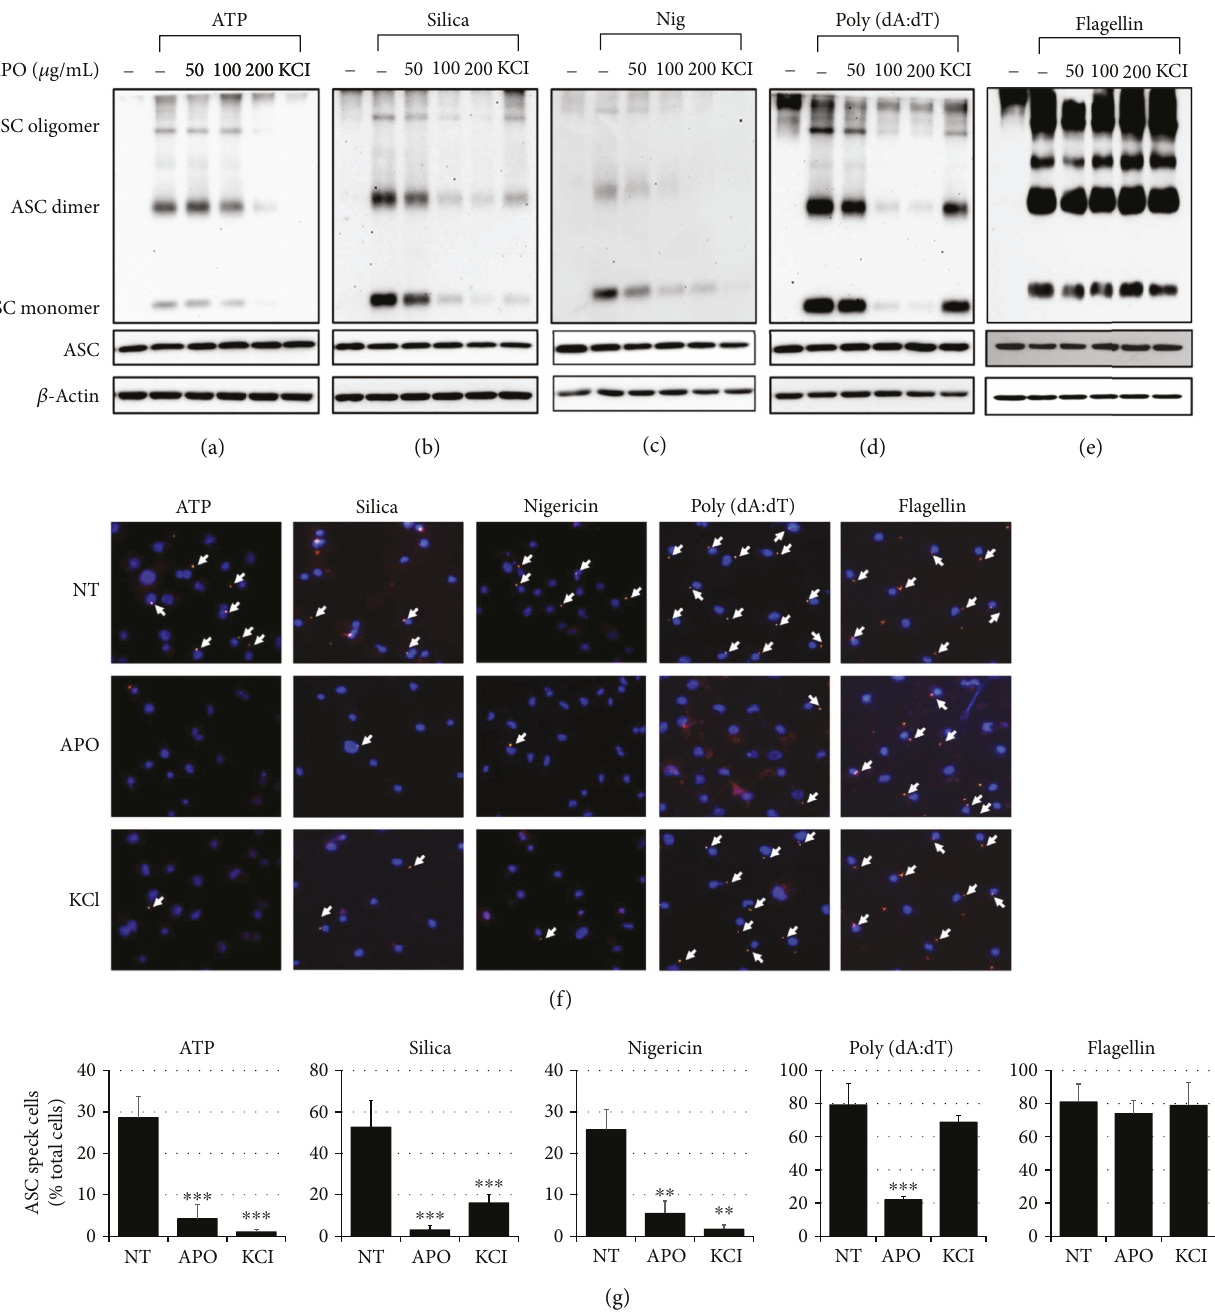
Figure 4: Inhibitory e ff ect of APO on ASC oligomerization. LPS-primed BMDMs were pretreated with APO or KCl (150mM), and ASC oligomerization in the cells was determined by Western blotting upon stimulation with (a) 5mM ATP for 1h, (b) 150 μ g/mL silica for 3h, (c) 10 μ M nigericin for 1h, (d) 2 μ g/mL poly (dA:dT) for 1h, and (e) 1.5 μ g/mL fl agellin for 3h. β -Actin is used as an internal control. (f) LPS-primed BMDMs were stimulated with 5mM ATP for 1h, 150 μ g/mL silica for 3h, 10 μ M nigericin for 1h, 2 μ g/mL poly (dA:dT)